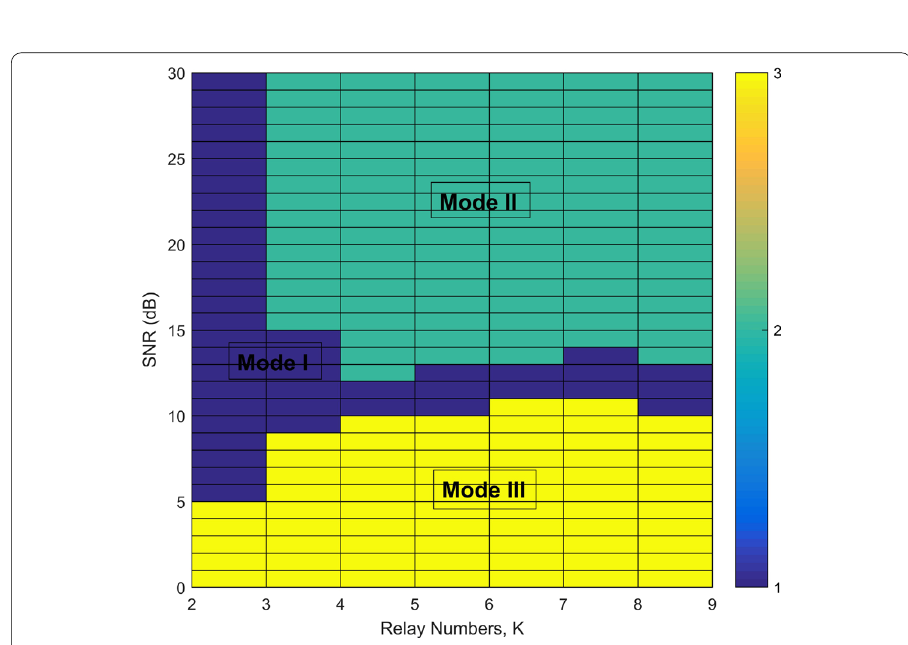
Fig. 5 The mode switch of the proposed HyIFD scheme as the SNR and relay numbers